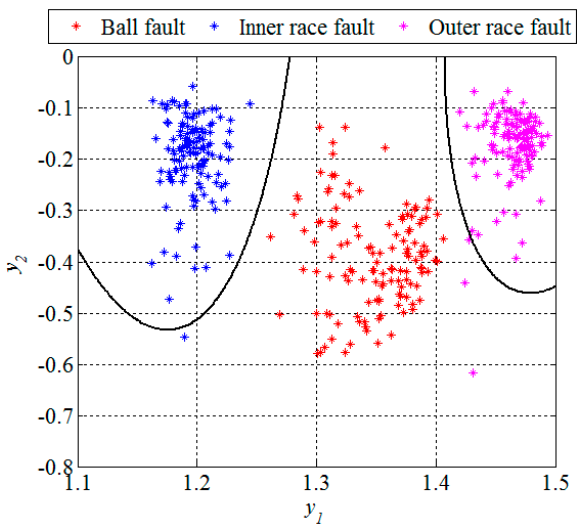
Figure 14. Dimension reduction and classification for the fault diagnosis, segments of the testing set. Table 4. Confusion matrix, segments of the testing set.